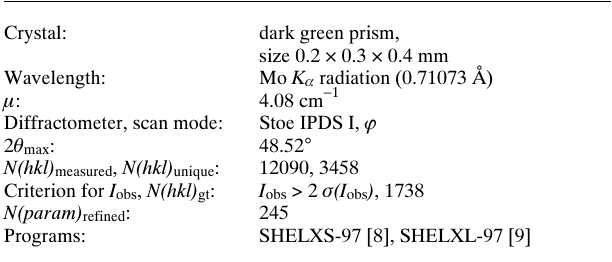
Table 1. Data collection and